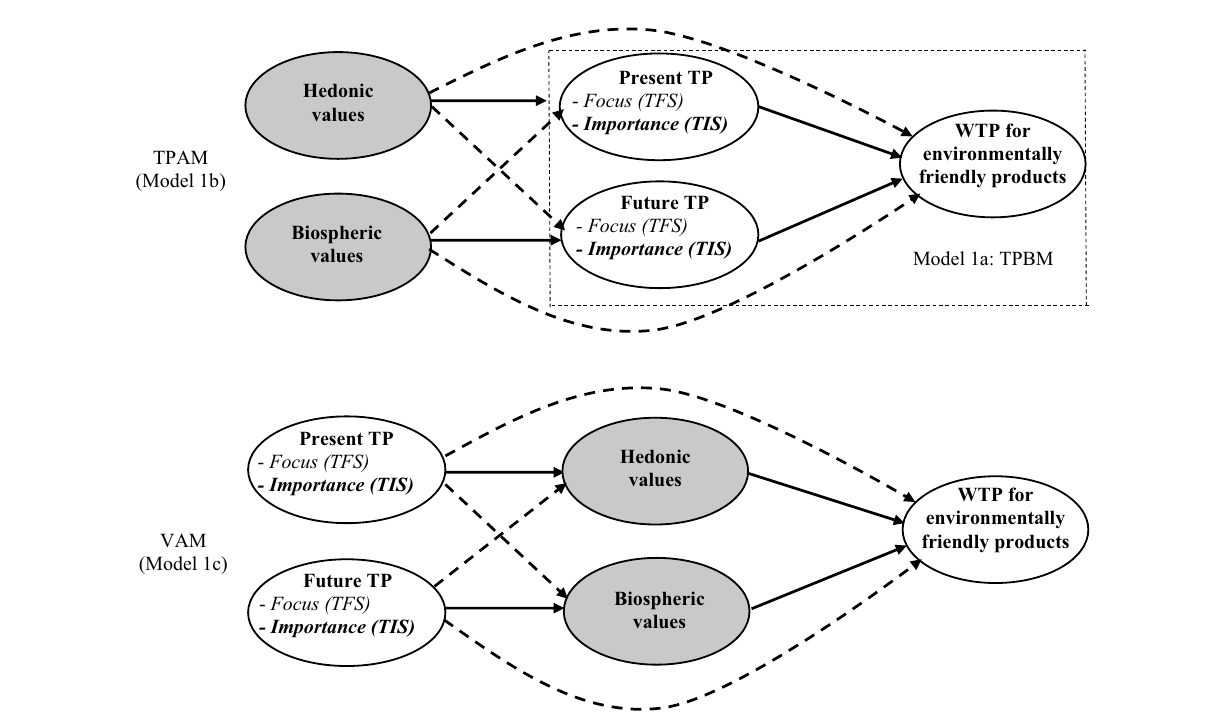
FIGURE 1 Alternative models for comparing time focus and time importance. Model 1a: Time perspective behavorial model (TPBM in the rectangle). Model 1b: Time perspective activation model (TPAM—total figure). Model 1c: Value activation model